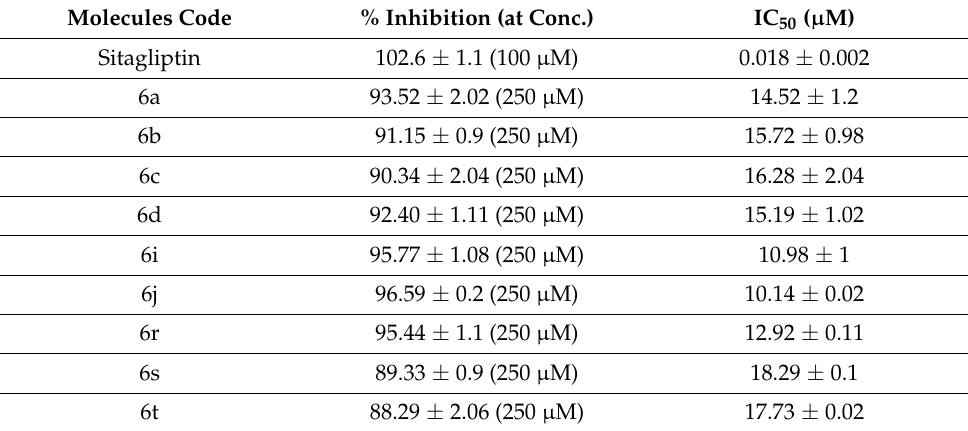
Table 1. % inhibition of standard and synthesized compounds along with IC 50 ( µ M) values ( n = 3, mean ±